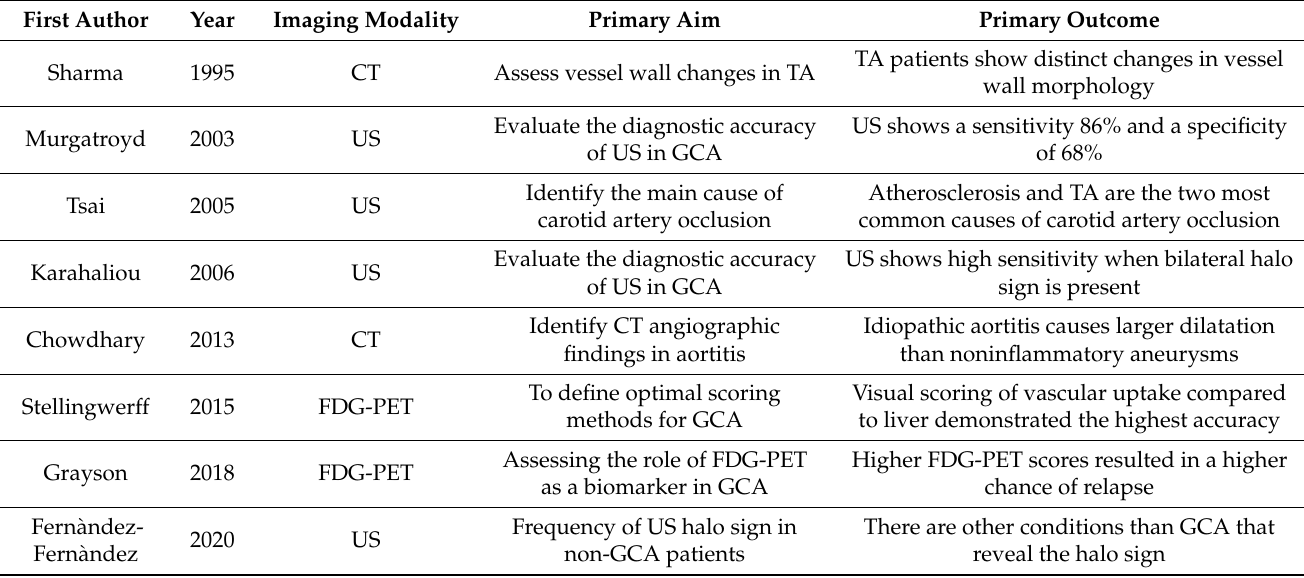
Table 1. Overview of the included studies and their aims and primary